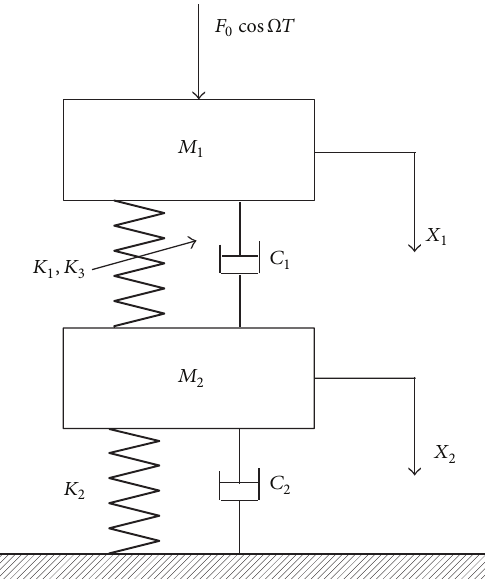
Figure 10: Two-degree-of-freedom vibration isolation model.